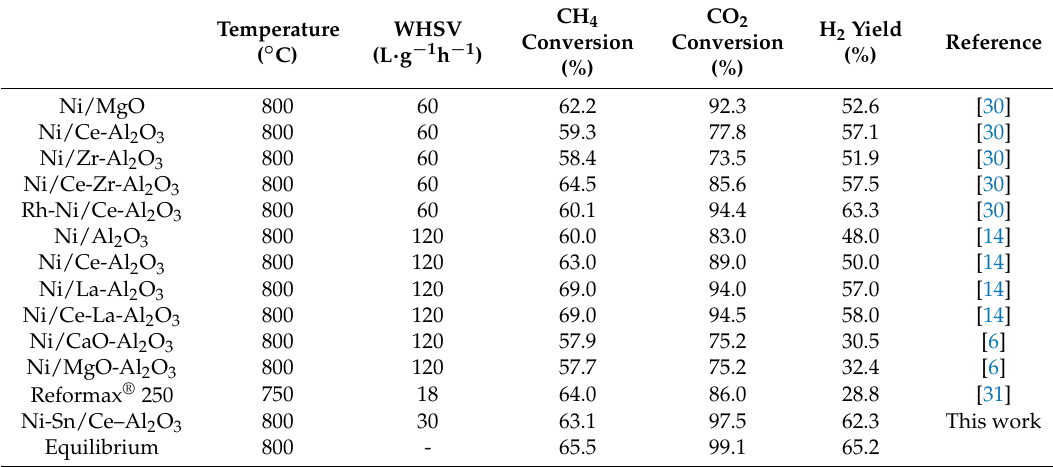
Table 3. Catalysts employed, and conditions used in catalytic biogas dry reforming, using CH 4 /CO 2 ratio: 1.5. WHSV: weight hourly space